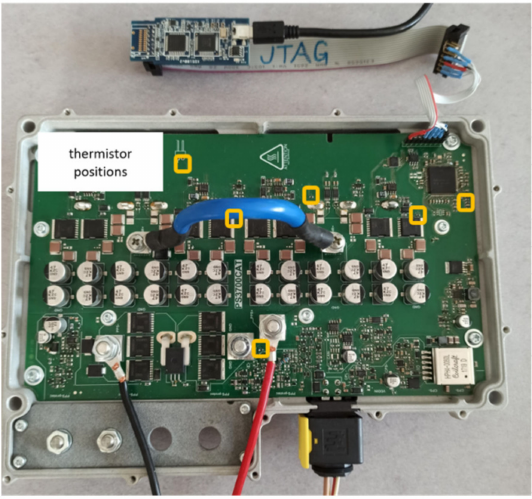
Figure 14. Experimental